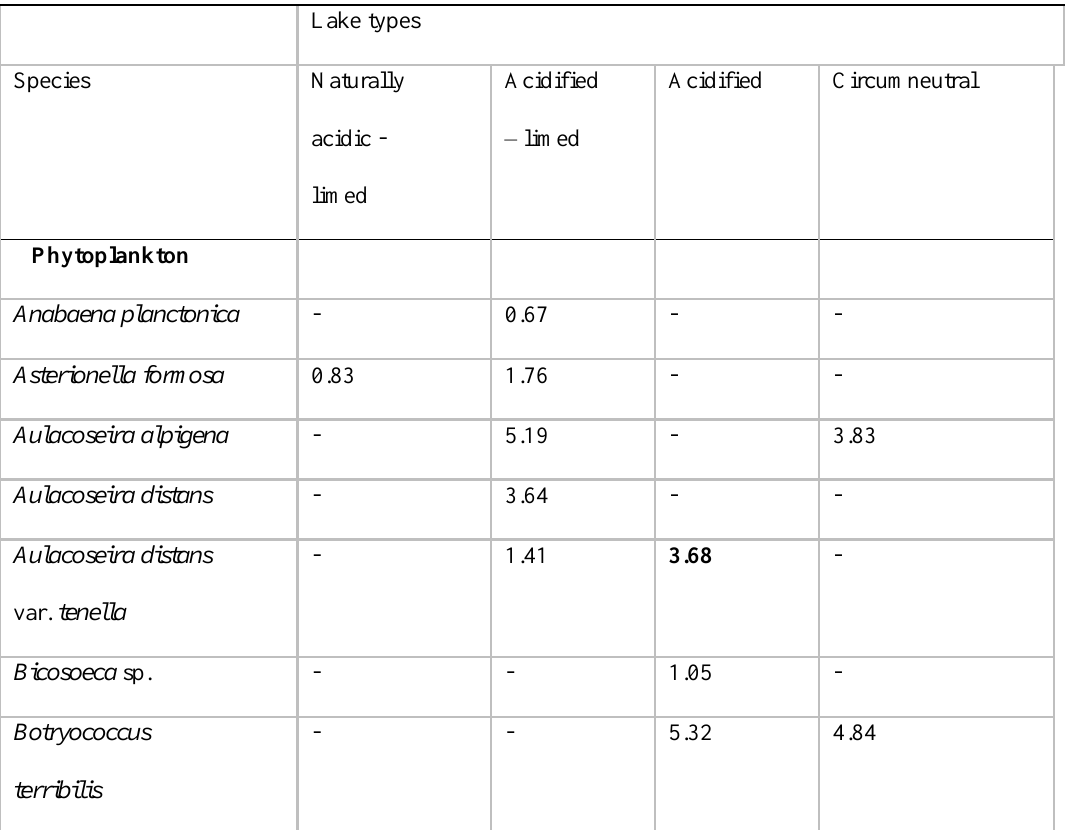
Table A1.1 : Results from Similarity Percentages (SIMPER) Analyses showing percentage contributions of phytoplankton, zooplankton, macroinvertebrate (in three habitat types; littoral, sublittoral, profundal) and fish to community composition in four different lake types (naturally acidic with liming, anthropogenically acidified with liming, acidified lakes without liming,